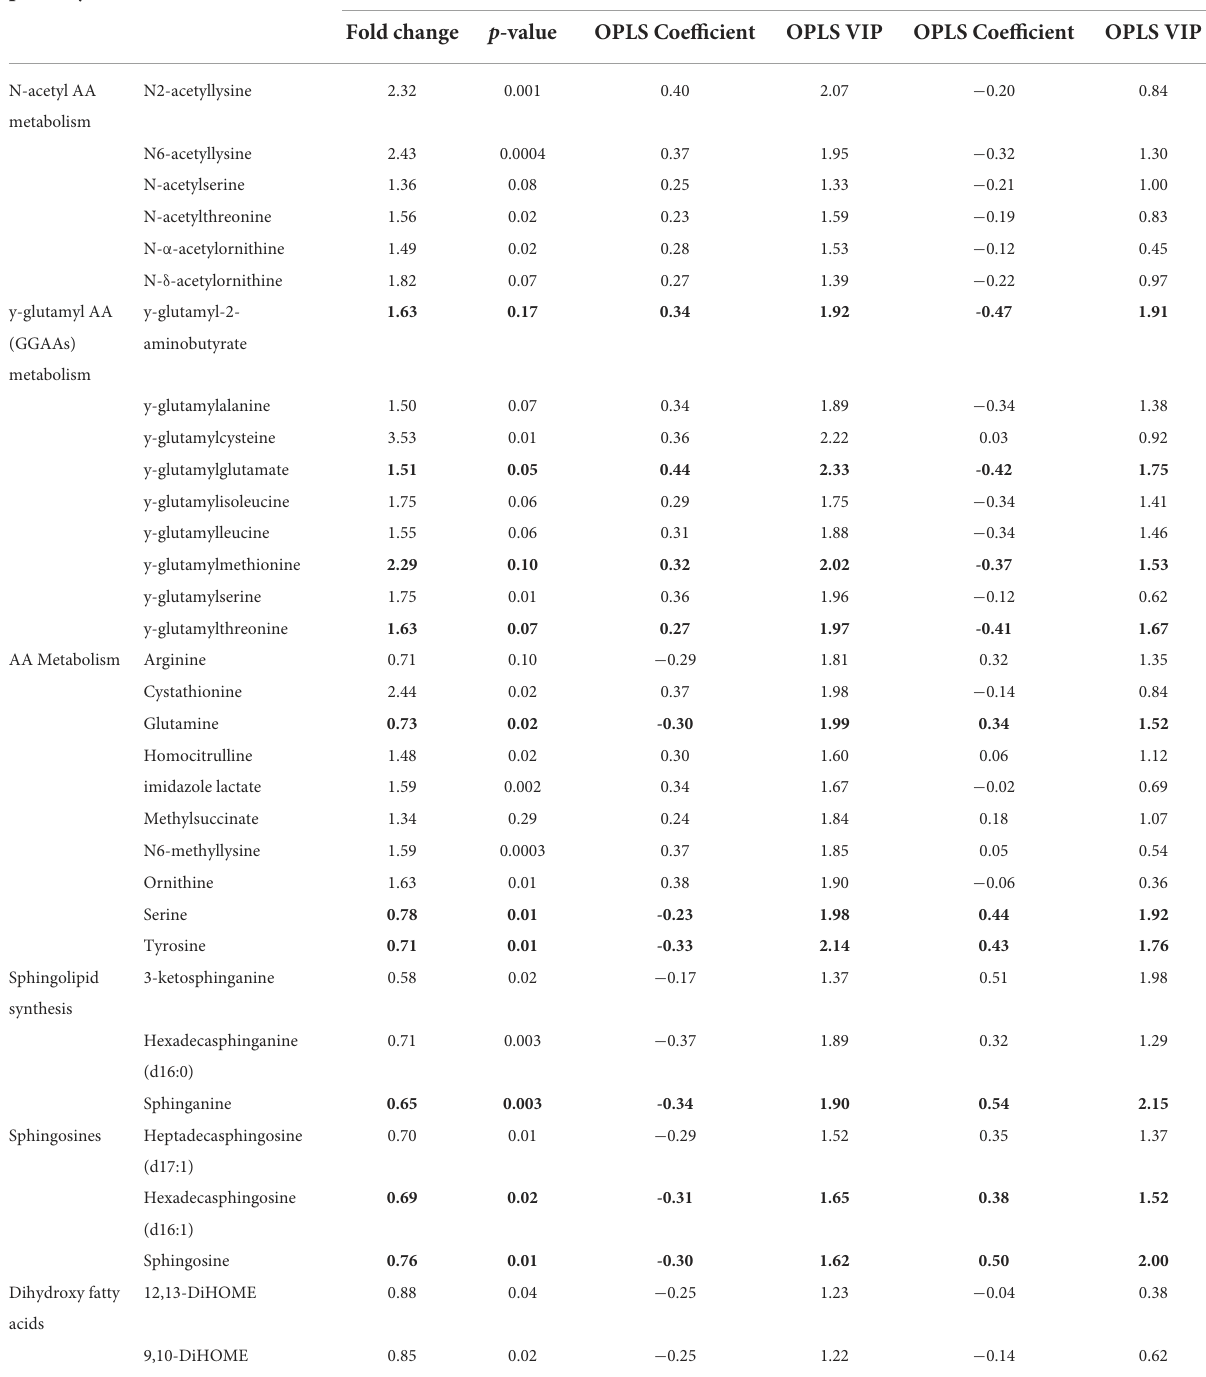
The table lists all measured metabolites annotated to the N-acetyl AA metabolism, gamma-glutamyl AA (GGAAs) metabolism, AA metabolism, sphingolipid synthesis, sphingosines, and dihydroxy fatty acids pathways, a complete list is provided in Supplementarymaterial1. Fold change: difference between 2-HMO and control formula; OPLS coefficient: correlation coefficient between the metabolite and the feeding group (i.e., 2-HMO or control formula) or the LRTI incidence, derived from multivariate model; OPLS VIP: weight of the variable in the multivariate models. Variables are highlighted in bold when significance above OPLS coefficient threshold (0.22) and an OPLS VIP threshold (1.5) for both treatment and LRTI